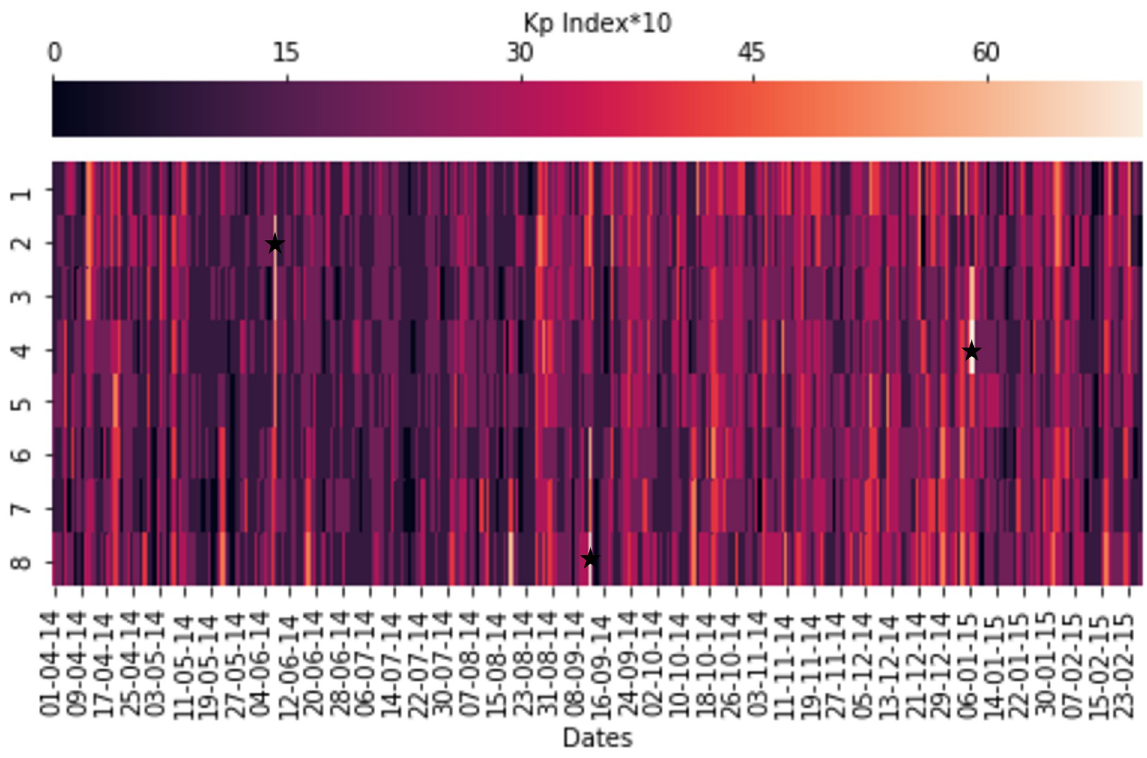
Fig 7. Planetary Kp-index, with the periods of high intensity annotated. Dobrovolsky formula R ¼ 10 0 : 43 � M w [9] with M